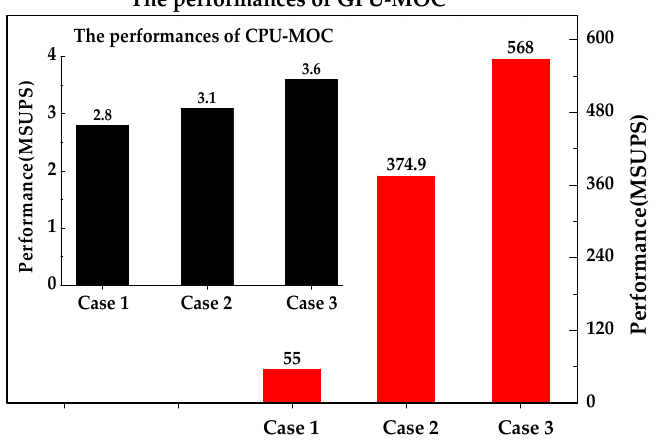
Figure 6. Performances of GPU-MOC and CPU-MOC in different section numbers.